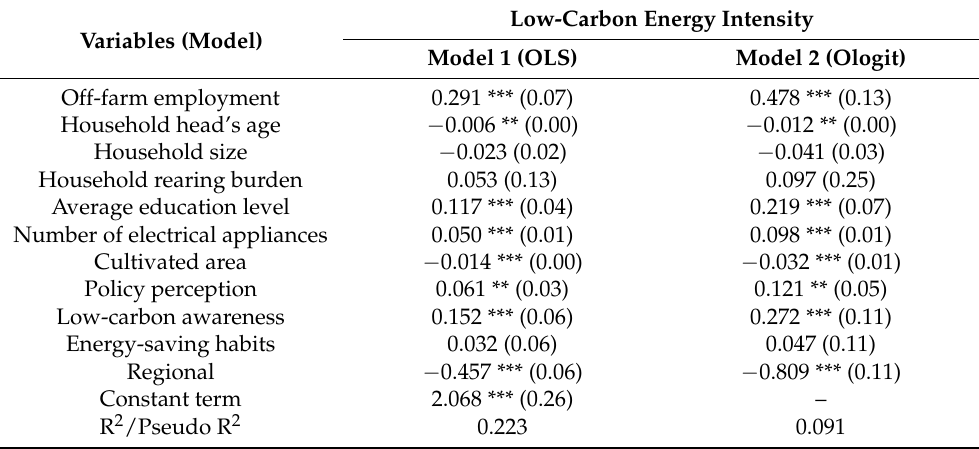
Table 2. Off-farm employment and farmers’ low-carbon energy intensity (N =